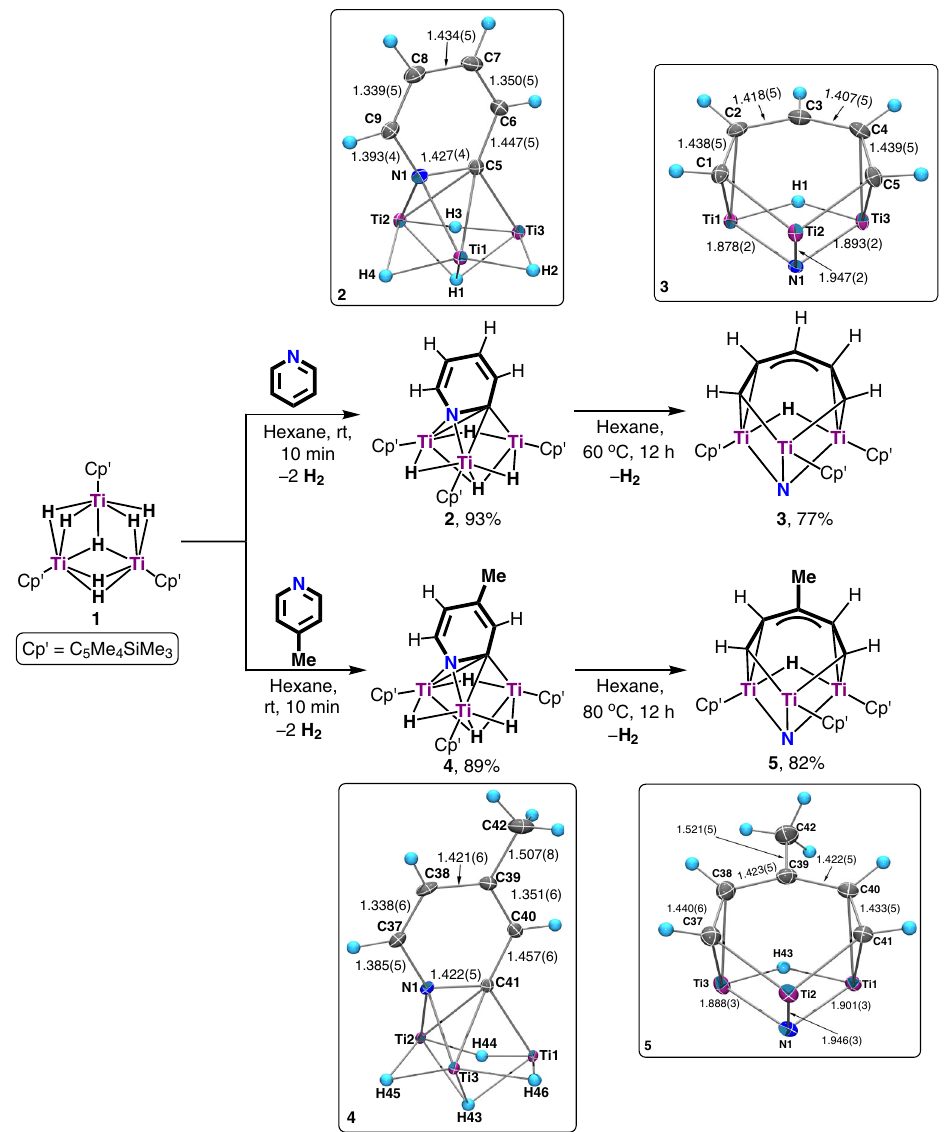
Fig. 2 Hydrodenitrogenation of pyridines by the titanium hydride complex 1 . Reactions of 1 with pyridine and 4-methylpyridine at room temperature gave 2 and 3 , which upon heating at 60 – 80 °C extruded the nitrogen atom from the pyridine unit to give 4 and 5 , respectively (Cp ′ = C 5 Me 4 SiMe 3 ). The X-ray structures of 2 , 3 , 4 , and 5 at 30% probability ellipsoids are shown in the square frames, with the C 5 Me 4 SiMe 3 ligands being omitted for clarity. The bond distances of 2 , 3 , 4 , and 5 are given in angstrom